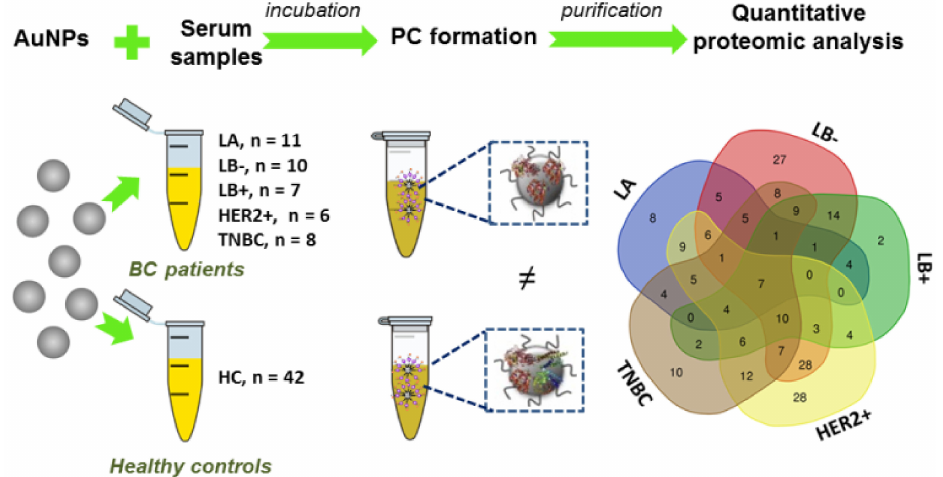
Figure 1. Simplified representation of the experimental procedure. AuNPs (12.96 ± 0.72 nm) were incubated ex vivo with human serum samples obtained from HC ( n = 42) and BC patients ( n = 42). Ex vivo corona-coated AuNPs were recovered and purified from unbound proteins by centrifugation. The formed PCs were quantitatively characterized, analyzed by SWATH-MS and compared between the